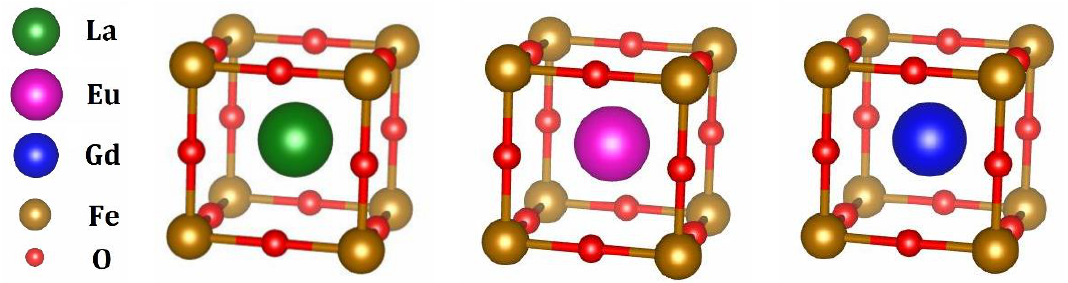
Figure 1. Schematic representation of crystal structures of RFeO 3 (R = La, Eu, Gd).